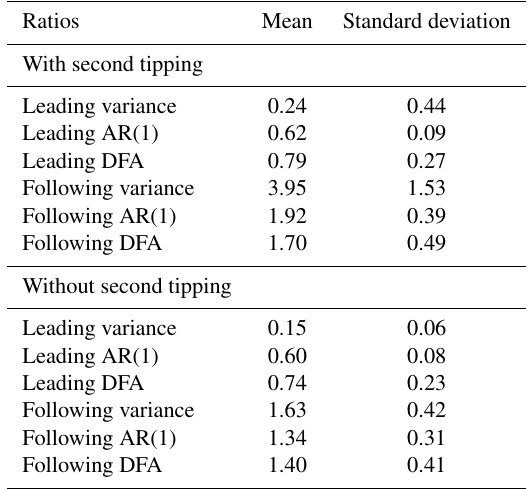
Table 3. Comparison of the ratios of auto-regressive variables prior to and after the first transition, using the ensembles shown in Figs. 3 and 4.